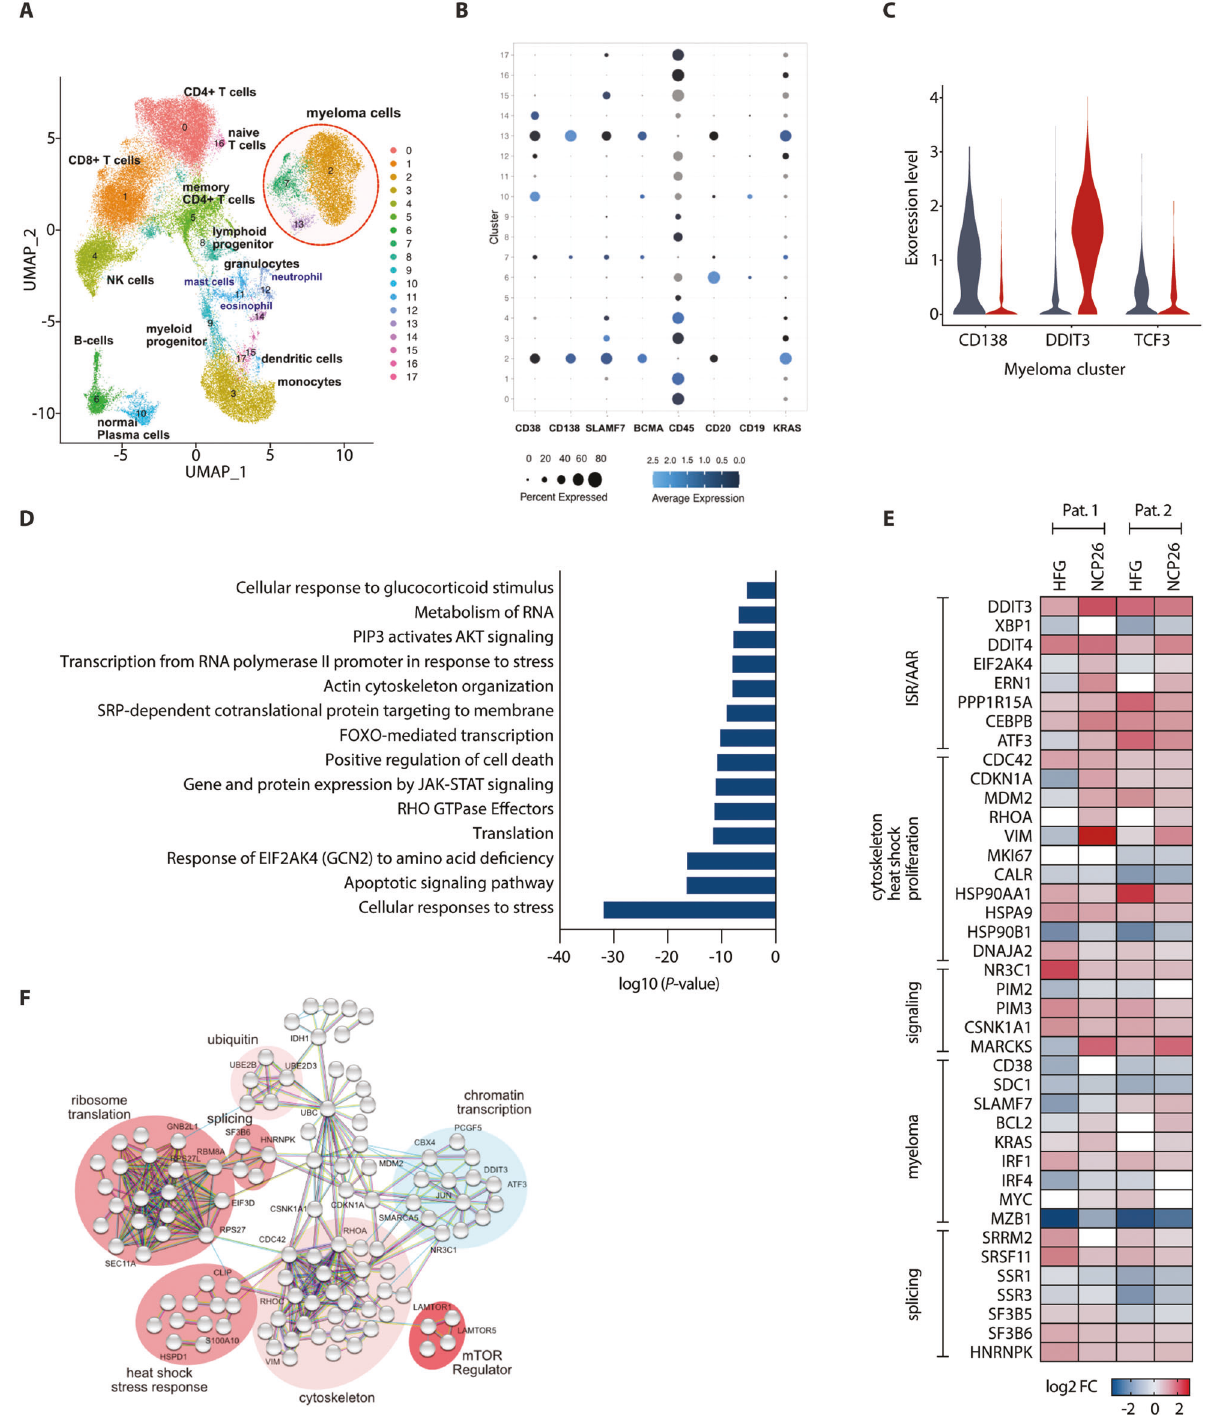
Fig. 6 Anti-myeloma activity of NCP26 and HFG in human MM bone marrow assays. A UMAP of single-cell RNAseq of human bone marrow samples (newly diagnosed MM), depicting major cell type clusters. B Dotplot of selected MM markers and cluster assignment. C Violin plot demonstrating the effect of NCP26 exposure (24 h) on myeloma cluster marker CD138 and NCP26 targets DDIT3 and TCF3. D Pathway analysis of top 200 regulated genes in myeloma subclusters. E Heatmap of selected differentially expressed genes after 24 h exposure with the PRS inhibitors HFG and NCP26. F STRING analysis of top regulated genes in the myeloma clusters after 24 h NCP exposure highlighting differentially regulated